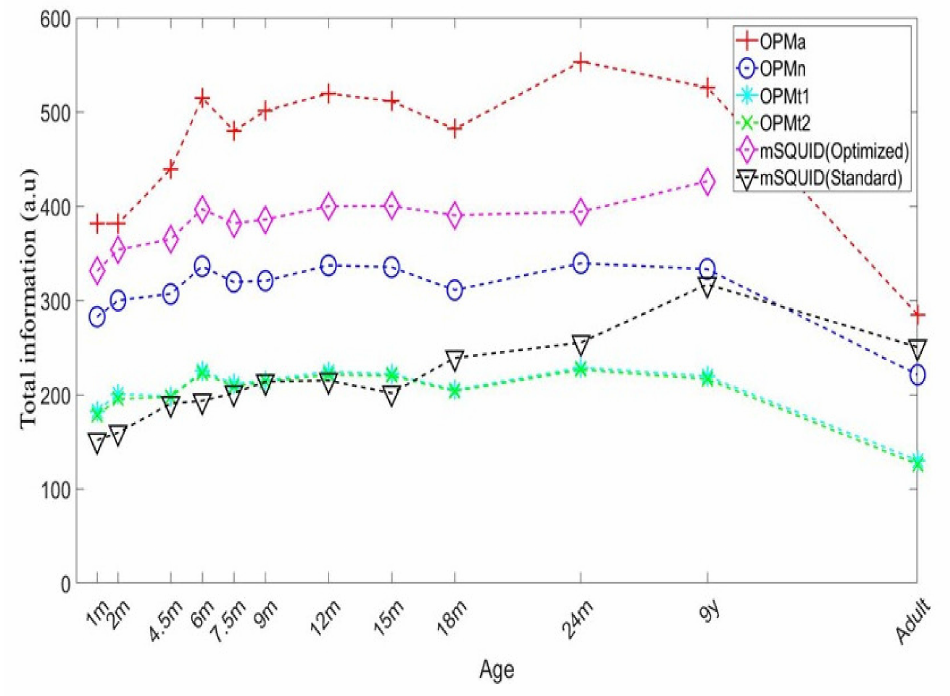
Figure 5. The total information capacities for the sensor arrays, by subject